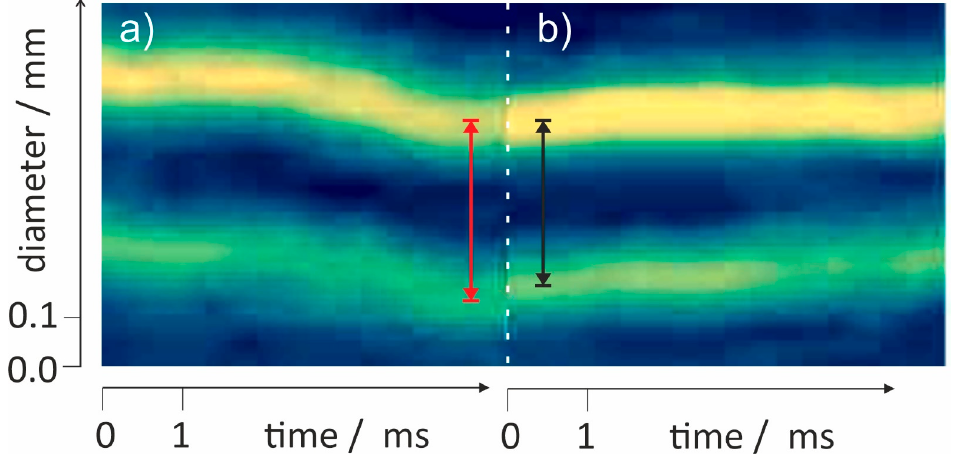
Figure 8. Magnified comparison of two instants in time from the time–space plot within a spike ( a ) and outside of a spike ( b ) of a water bridge run at 19 kV and 1.0 mA, bridge temperature ~50 °C, from Figure 7. While the regular surface wave observed at 100 Hz frequency can be discussed in terms of EHD, these irregular spikes deserve a closer look. In order to locate and describe this phase transition in the water bridge experiment, we first need to point out both similarities and differences between the aforementioned experiment using a needle-plate set-up [34] and the water bridge. There are two important differences: